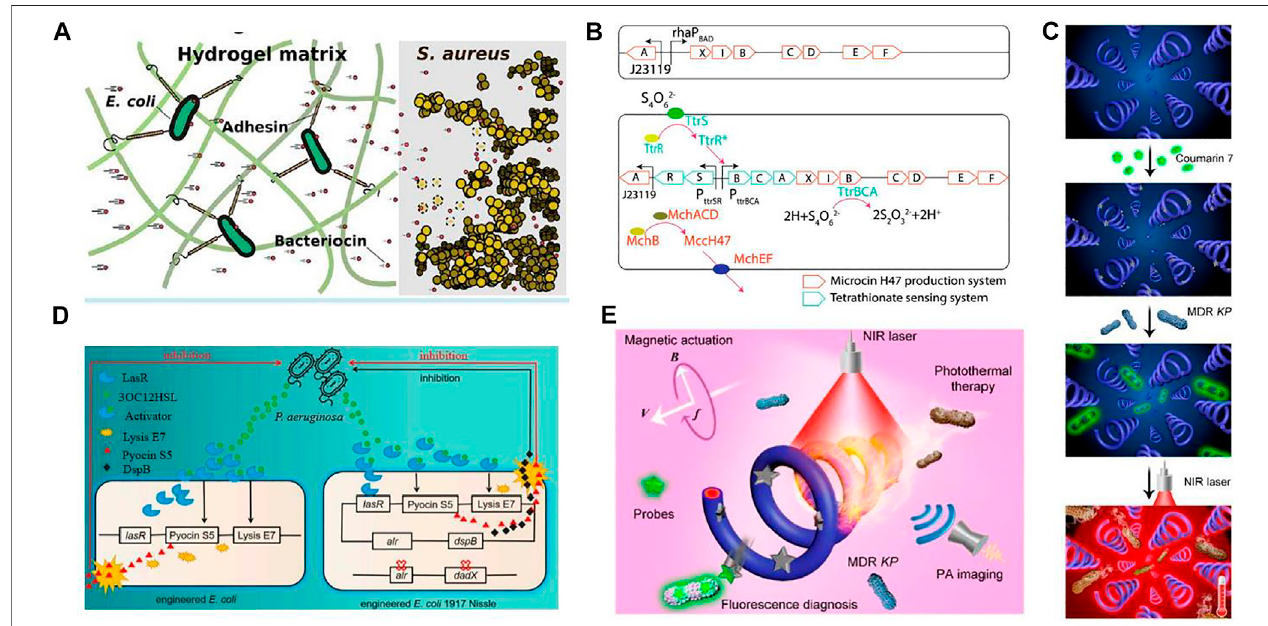
FIGURE 6 | Applications of engineered bacteria for treating infection. (A) A novel ELM 'PATCH' has been designed: The engineered E. coli release antimicrobial enzymesinahydrogelmaterialtotarget S.aureus .ReproducedwithpermissionfromGuoetal.(2020),Copyright2020,AmericanChemicalSociety. (B) Theengineered EcN consists of a plasmid system carrying mchAXIBCDEF and ttrRSBCA, producing MccH47 in the presence of tetrathionate. As a result, inhibit and compete with the growth of Salmonella. Reproduced with permission from Palmer et al. (2018), Copyright 2018, American Chemical Society. (C) In vitro testing of fl uorescence (on-